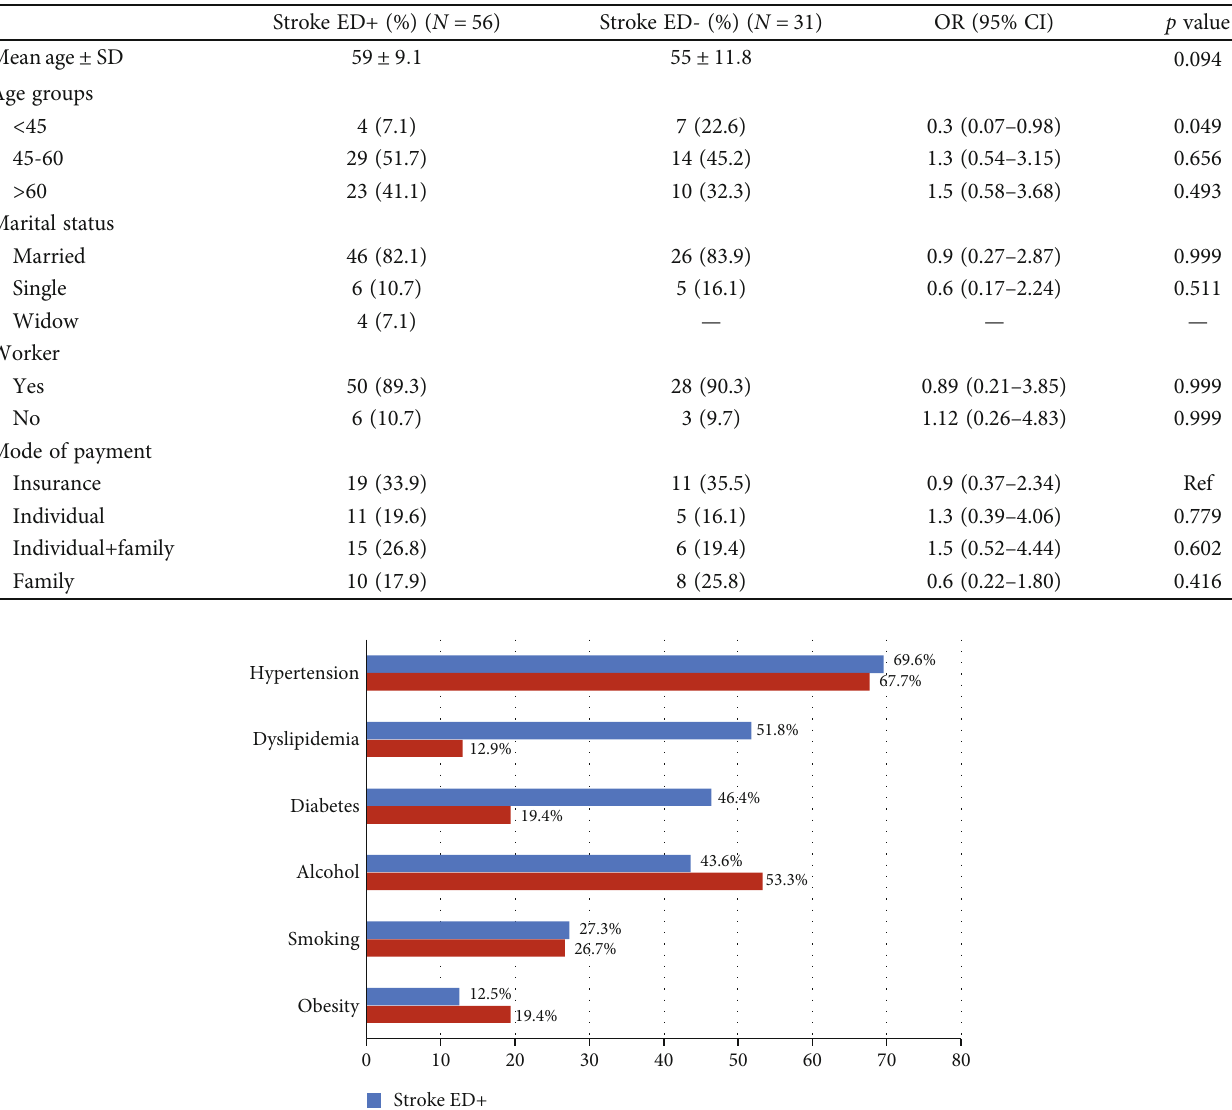
Table 2: Sociodemographic characteristics of stroke+ populations.